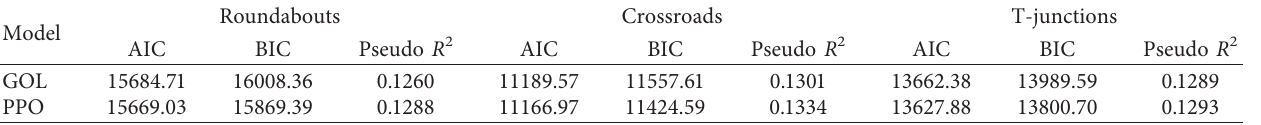
Table 5: Indicators for model comparison.